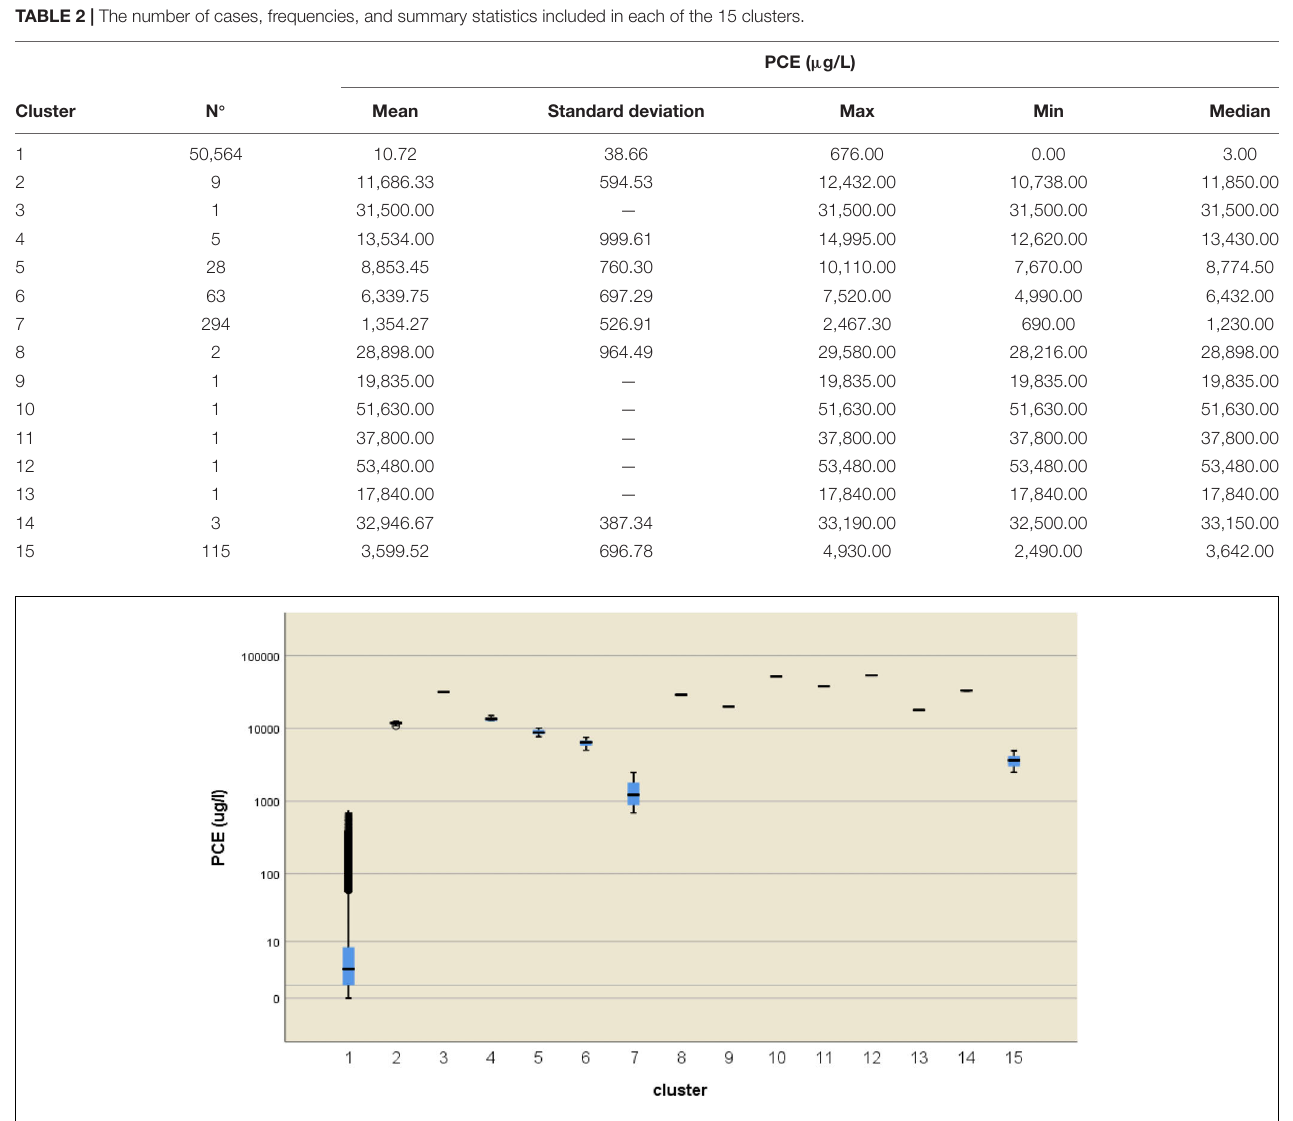
FIGURE 6 | Representation of 15 clusters identified through CA using boxplots in a logarithmic scale for the PCE concentrations ( µ g/L).